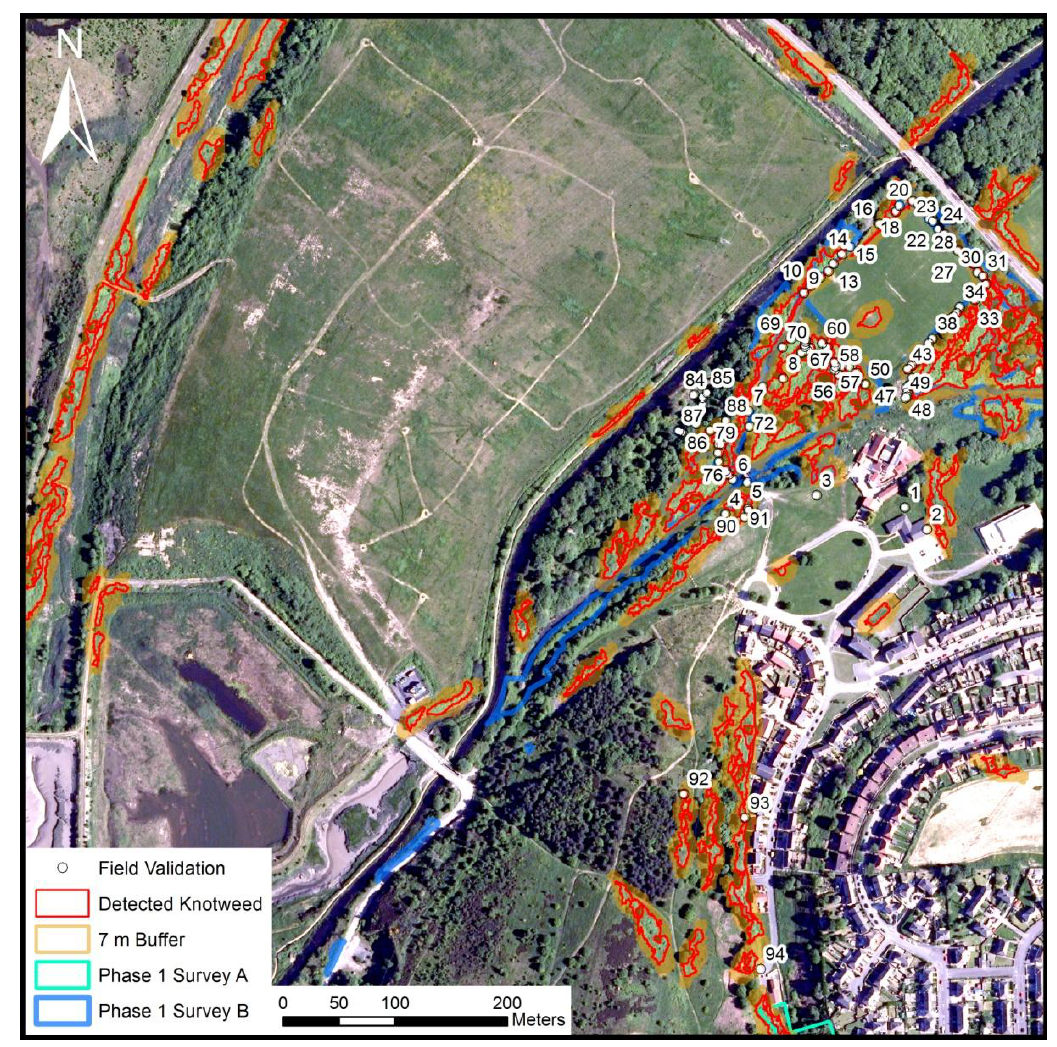
Figure 9. Field validation of Giants Grave training site, Briton Ferry (South Wales, UK), showing GPS field survey data (51°64′43.0″N, 03°8′24.85″W). Please refer to title and legend for further information.